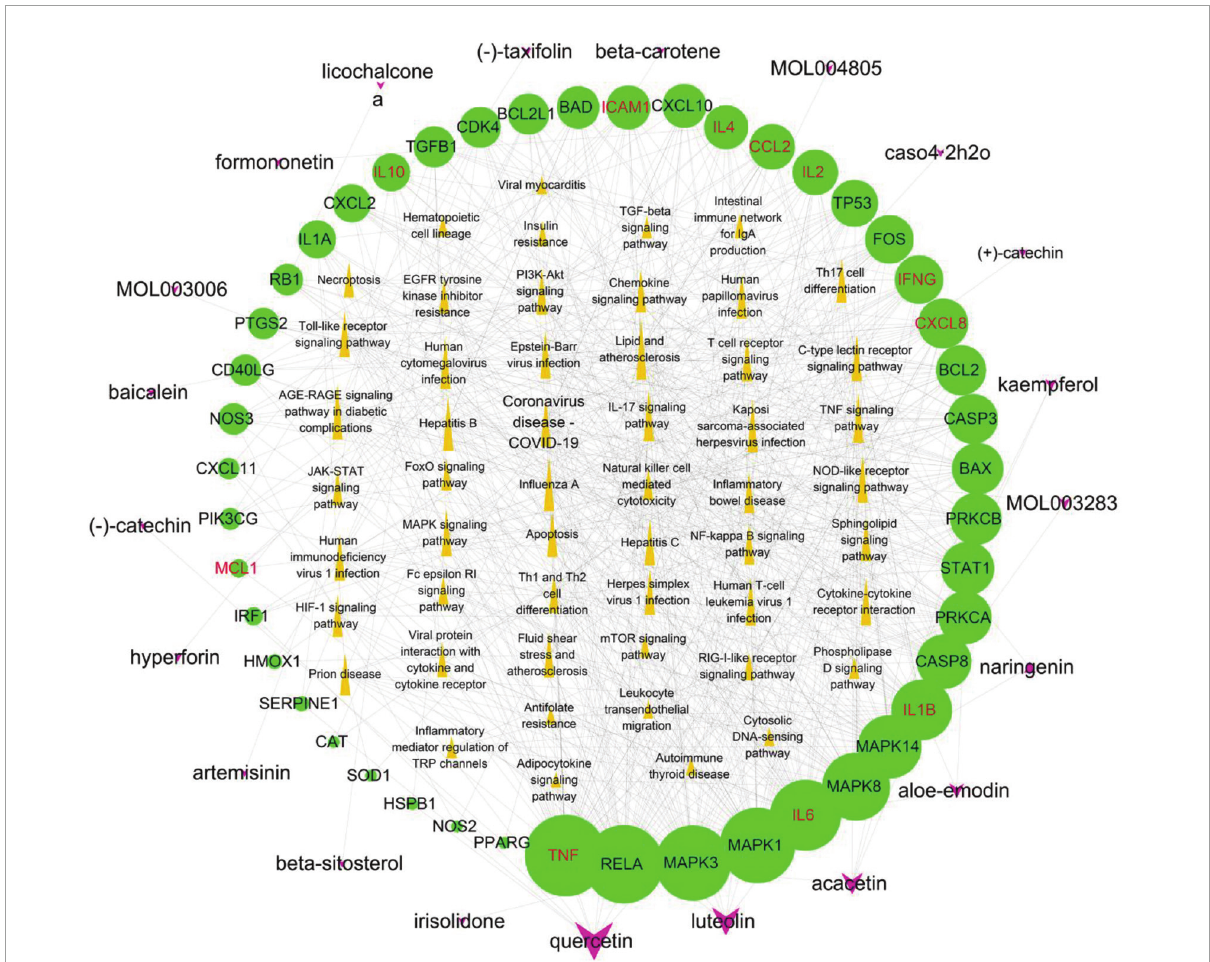
FIGURE9 Potential active component-potential target–pathway network. Green circles represent action targets, yellow triangles represent the 53 signaling pathways associated with Hub genes, and rosy V shapes represent the four prescribed active ingredients. The node size is positively related to the degree, and the edges represent the interactions between the